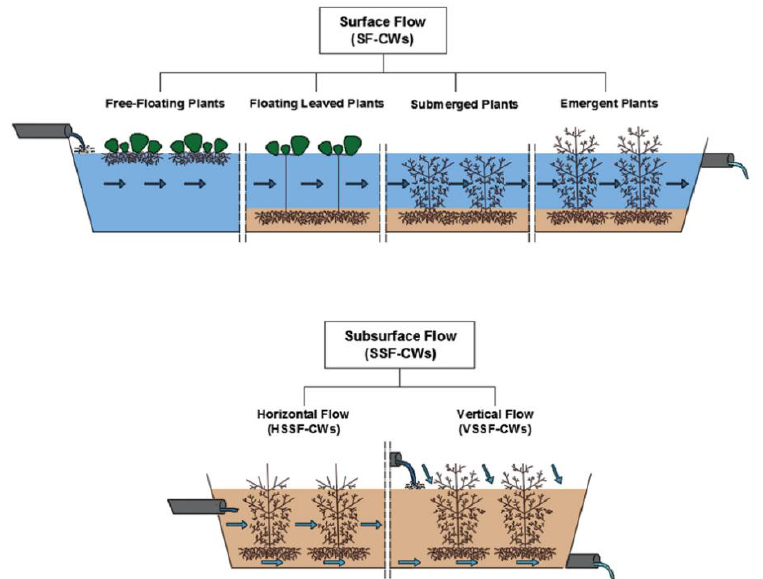
Figure 1. CWs configurations, according to hydrology (surface or subsurface flow), plant growth forms for surface flow (free-floating, floating leaved, submerged or emergent) and flow path for subsurface flow (horizontal or vertical). Reprinted from Environmental Pollution, Vol 227, Ana M.